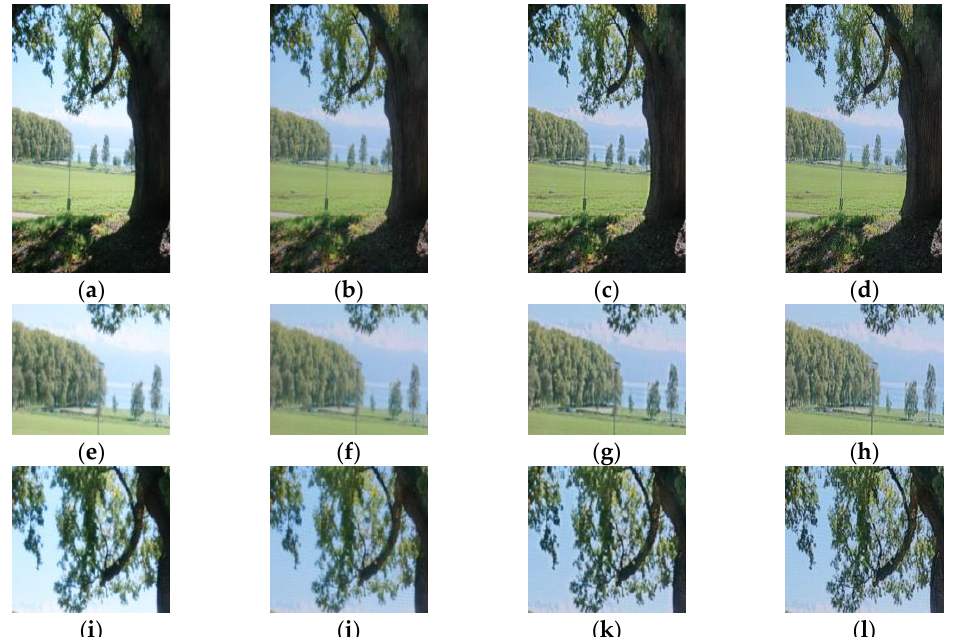
Figure 1. Comparison of different tone-mapped images with different supply voltages (brightness) of an AMOLED panel: ( a ) original tone-mapped image with the best MOS value, avg. luma = 117.3, brightness = 200; ( b ) Reinhard global TMO, avg. luma = 142.9, brightness = 100, power saving = 27.3%; ( c ) Reinhard local TMO, avg. luma = 144.3, brightness = 100, power saving = 25.9%; ( d ) Reinhard global TMO + unsharp masking, avg. luma = 143.1, brightness = 100, power saving = 25.1%; ( e – l ) are locally cropped enlargements of ( a – d ).